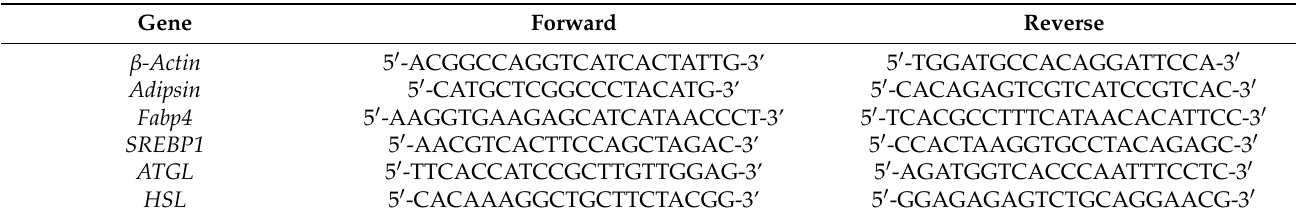
Table 2. Sequences of primers used for